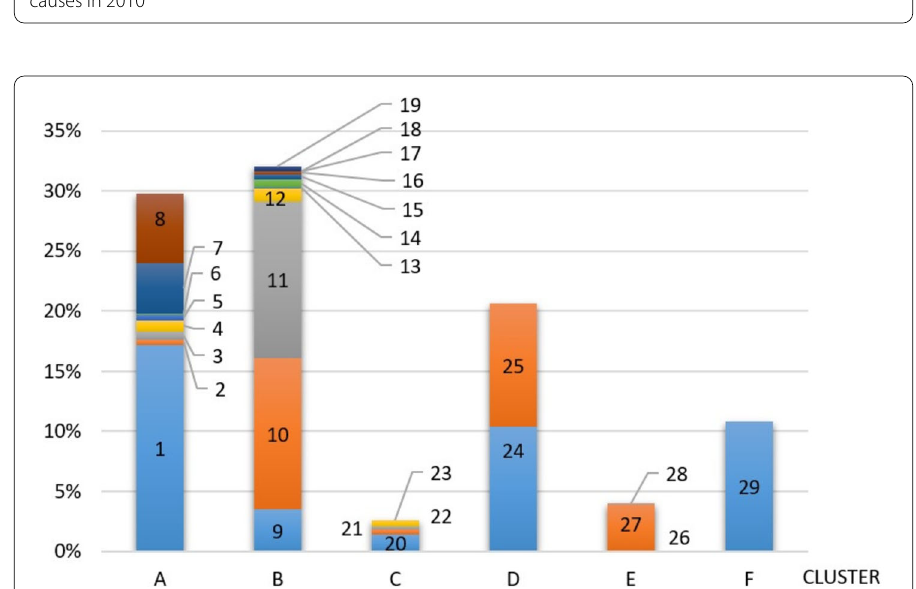
Figure 2 Groups (numbers as in the left column of the Table 3) and six clusters of the failures’ causes in January–July 2014